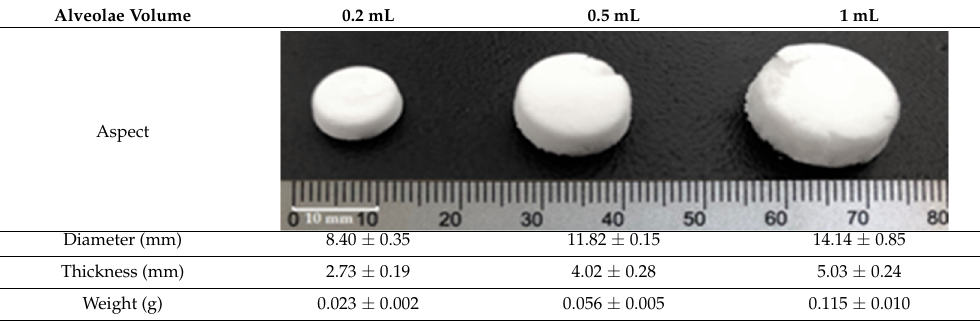
Table 4. Model performance parameters for the DoE work set.